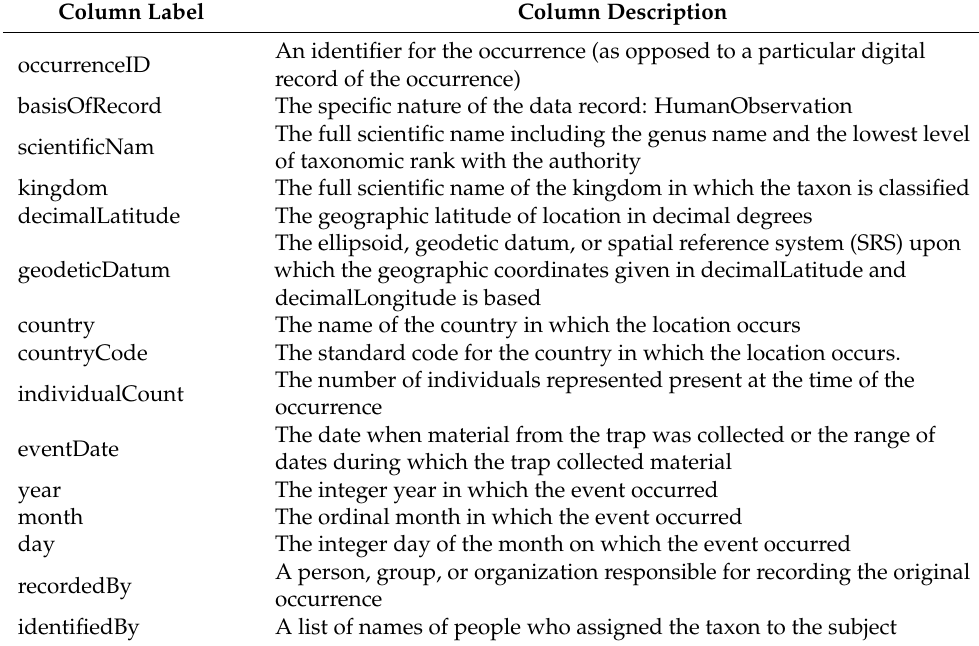
Table 1. Description of the data in the dataset.